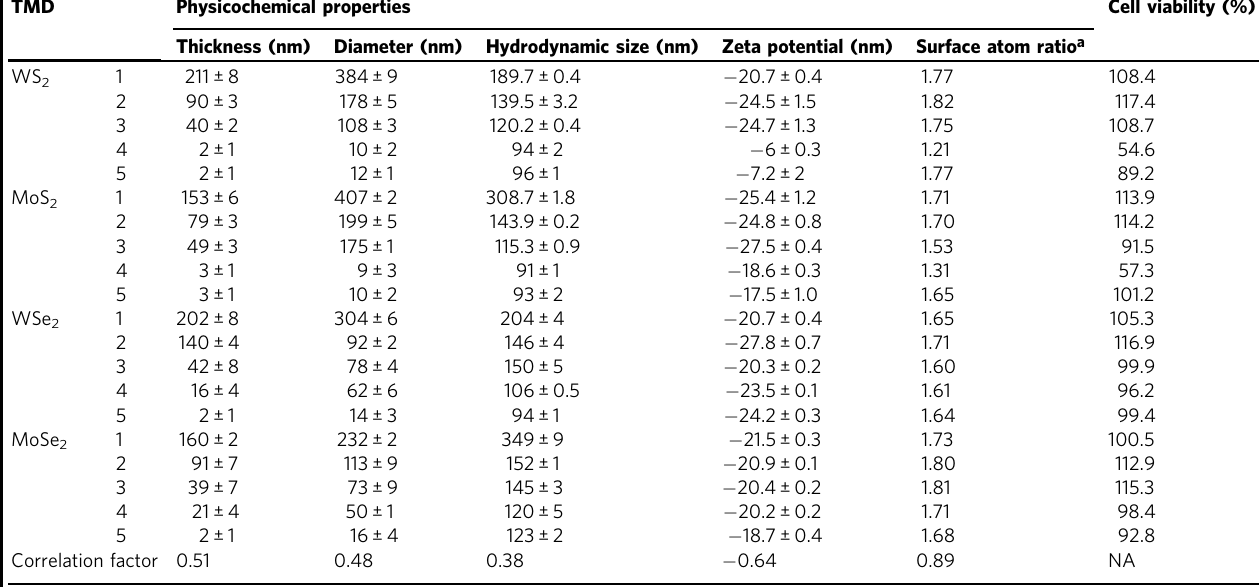
Table 1 Correlation analysis between cell viability and physicochemical property.